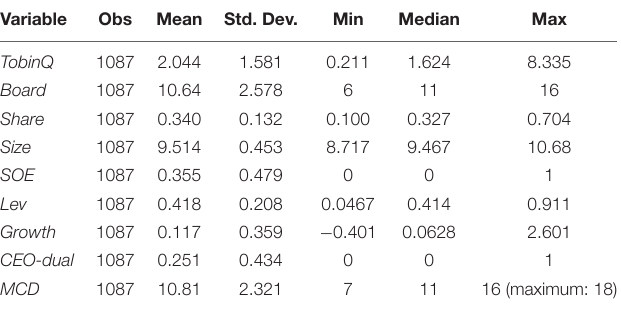
TABLE 3 | Descriptive statistics.